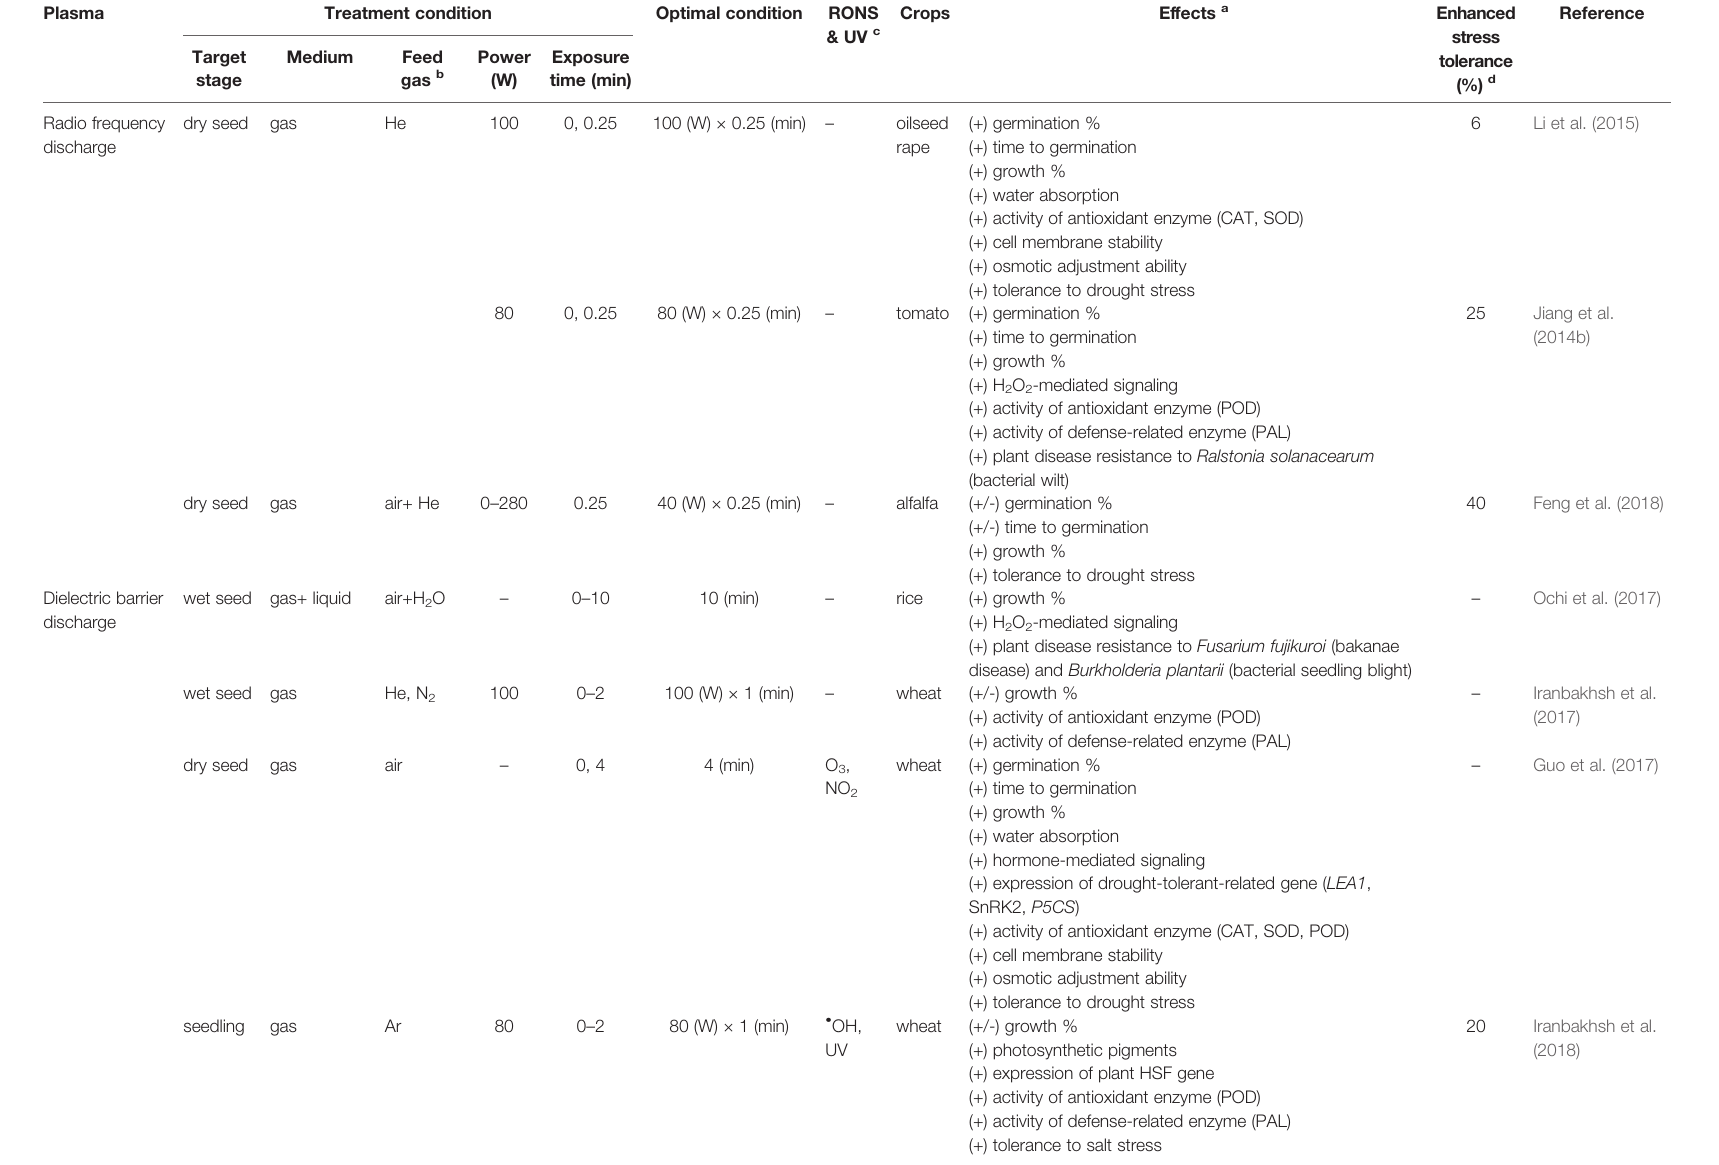
TABLE 4 | The plasma effects on stress tolerance in